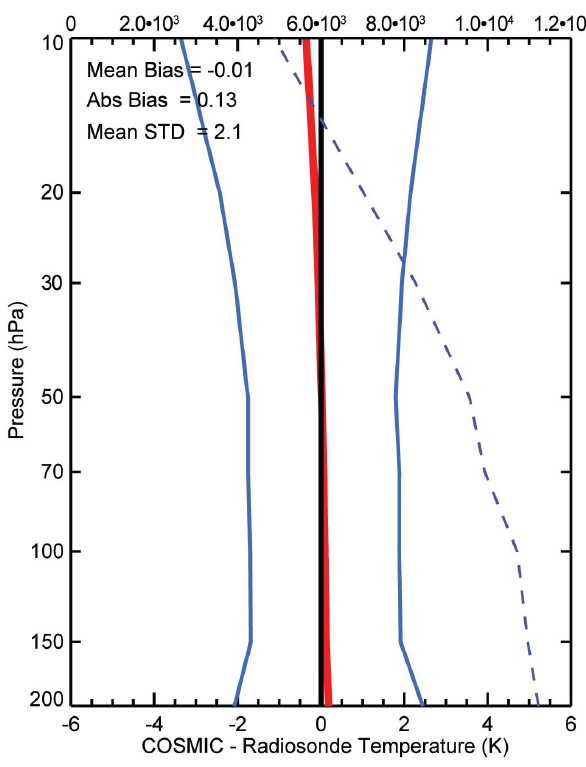
Fig. 6. Statistics of a comparison between COSMIC and high- resolution, accurate radiosondes between 10 and 200hPa. This comparison shows that the accuracy of RO observations in this re- gion is 0.13K or higher. The number of pairs in the comparisons is shown by the blue dashed line and the scale at the top. The mean difference is shown by the red line and the standard deviation of the differences by the solid blue lines (Ho et al.,